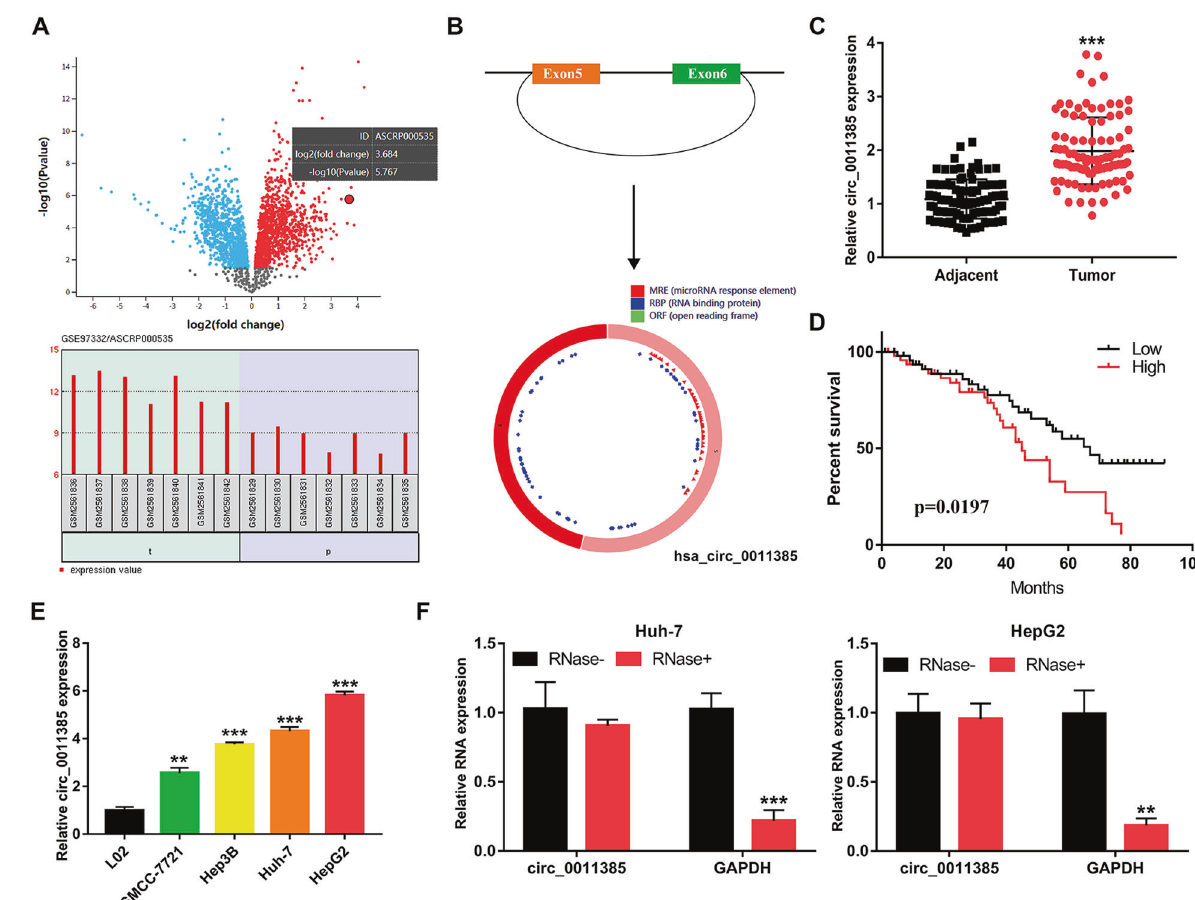
Fig. 1 Circ_0011385 is upregulated in HCC tissues and cells. A Dysregulated circRNAs in GSE97332 were assessed, and circ_0011385 was chosen for study. B Schematic drawing illustrating that hsa_circ_0011385 arises from exons 5 and 6 of the EIF3I gene. C Validated circ_0011385 expression in HCC tissues and adjacent tissues. D Overall survival analysis based on circ_0011385 expression in 96 patients with HCC. E Relative circ_0011385 expression in HCC and L02 cell lines. F The expression levels of circ_0011385 in Huh-7 and HepG2 cell lines after treatment with RNase R. Data (n = 5) are the means ± SD. *P < 0.05, ** P < 0.01, *** P < 0.001. and adjusted P value, we found that circ_0011385 expression was signi fi cantly higher in tumor tissues (Fig. 1A). According to the UCSC Genome Browser, circ_0011385 was generated from back-splicing of the 5th and 6th exons of the EIF3I gene (Fig. 1B). We then performed qRT-PCR analysis on 96 patients with HCC, which indicated that circ_0011385 expression was signi fi cantly elevated in HCC tissues (Fig. 1C). To demonstrate the clinical signi fi cance of the upregulation of circ_0011385, we analyzed the clinicopathological characteristics of patients with HCC. Using the median expression level as a cut-off value, we divided our patient cohort into two groups: a high expression group ( n = 54) and a low expression group ( n = 42). As shown in Table 1, the expression level of circ_0011385 varied with tumor size and TNM stage, but not with age, sex, HBV infection, and liver cirrhosis. In addition, patients with high expression of circ_0011385 had a poorer prognosis than those with low expression (Fig. 1D). Moreover, circ_0011385 was upregulated in all four HCC cell lines (SMCC- 7721, Hep3B, Huh-7, and HepG2) (Fig. 1E). After RNase R treatment, the expression levels of circ_0011385 in Huh-7 and HepG2 cell lines did not change signi fi cantly, thus, indicating that circ_0011385 exists stably in cells (Fig. 1F). The above results suggested that circ_0011385 may be involved in the pathogenesis of HCC.